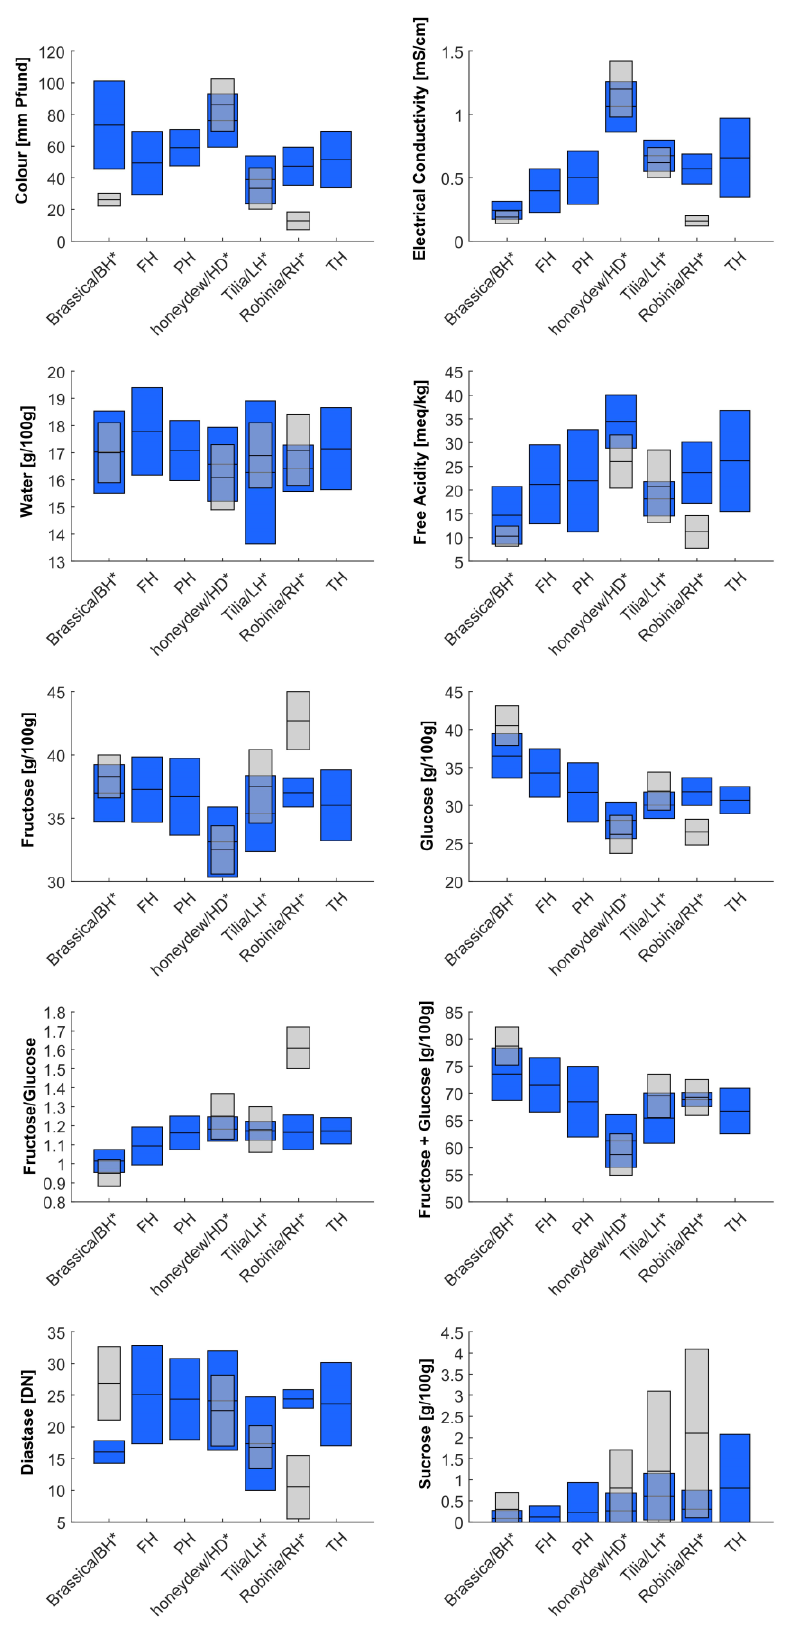
Figure 2. Variability of the various parameters in European and Czech honey. Grey—European honey [9]; blue—Czech honey.